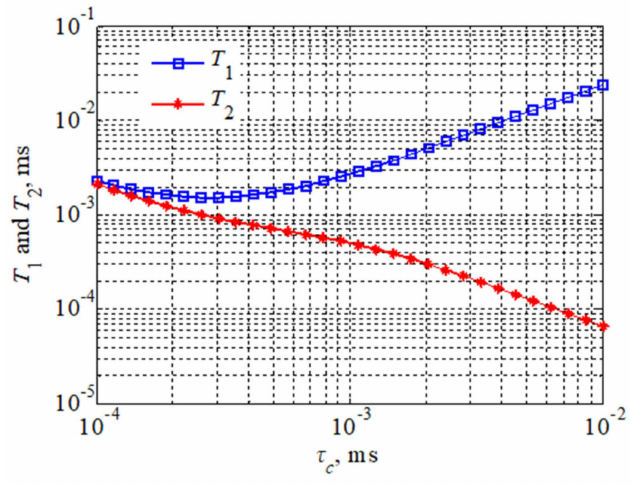
Figure 1. Theoretical plots of T 1 and T 2 relaxation times versus Larmor frequency and correla- tion